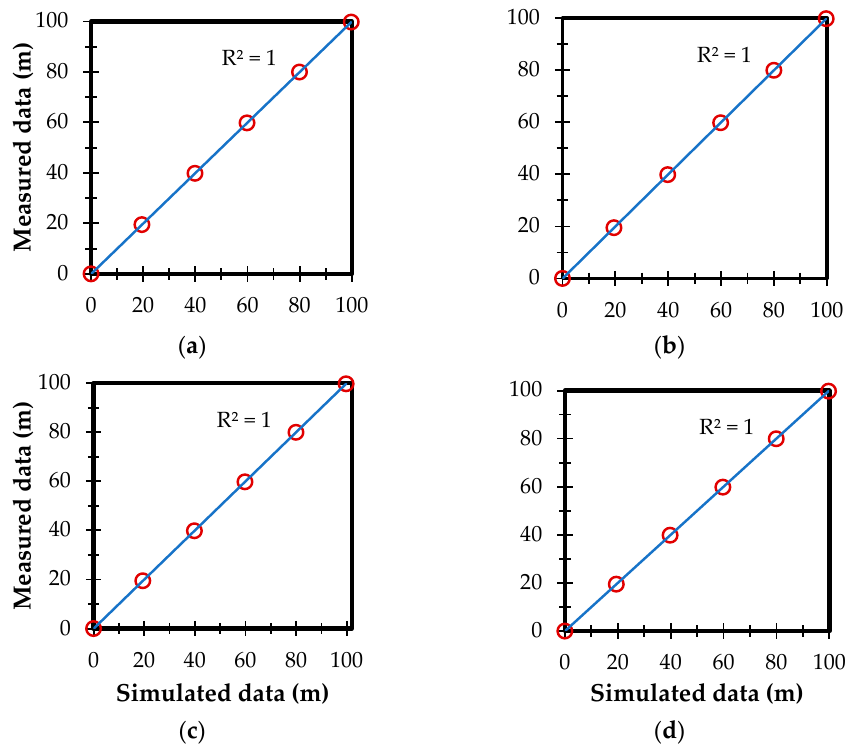
Figure 9. Relationship between measured data and data simulated by the model with optimized parameters at different time steps: ( a ) δ t = 1.5 s; ( b ) δ t = 2.0 s; ( c ) δ t = 5.0 s; ( d ) δ t = 10.0 s.